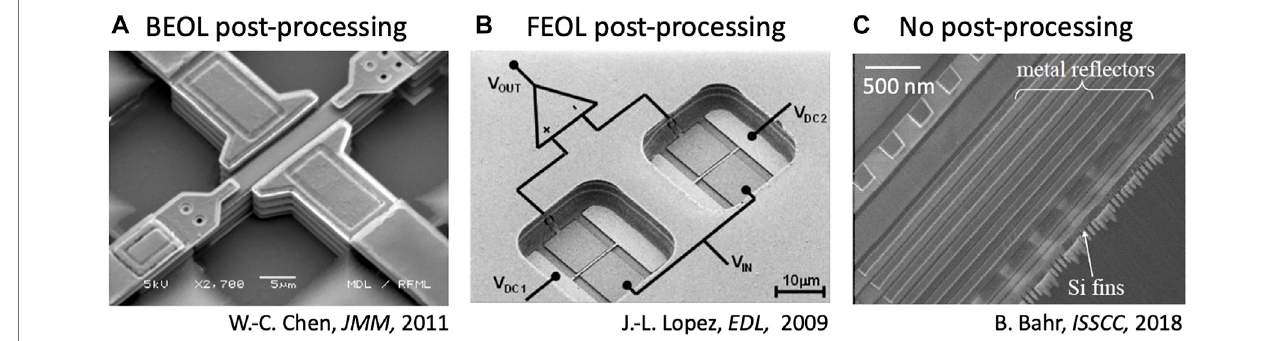
FIGURE 1 | Scanning Electron Micrographs as representative examples of post-processing approaches for CMOS-MEMS devices. (A) Sacri fi cial etching of Back End of Line (BEOL) layers in CMOS to generate suspended MEMS structures in metal and dielectric layers (Chen et al., 2011). (B) Post-processing of both BEOL and FEOL layers to create suspended MEMS devices using high-quality FEOL materials such as the polysilicon gate layer (Lopez et al., 2009). In both (A , B) , CMOS-MEMS transducers are air-gap capacitors for both drive and sense. (C) Solid-state CMOS-MEMS resonators with no post-processing to the standard CMOS chip (Bahr et al., 2018). Devices are not released, with acoustic waveguides designed from BEOL and FEOL layers to sustain acoustic modes. Periodic structures along the wafer de fi nefrequency,dispersioncharacteristics, andlateral con fi nementoftheacousticvibrations inthechip.Transductionleverages thetransistorgatedielectricfordriving acoustic modes, and transistor drain current for sensing vibrations. Figures © IEEE, reprinted with